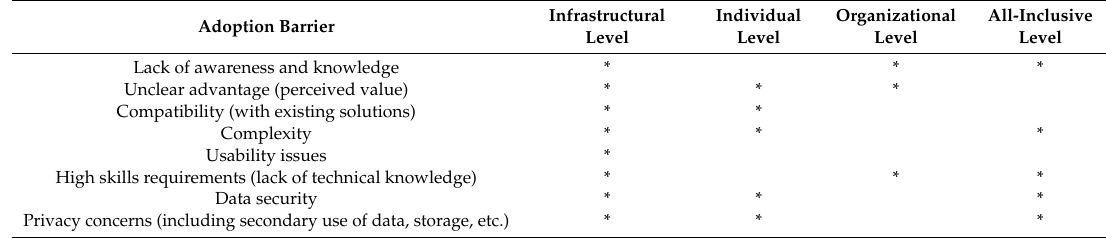
Table 2. Summary of adoption barriers at four application levels of internet of things